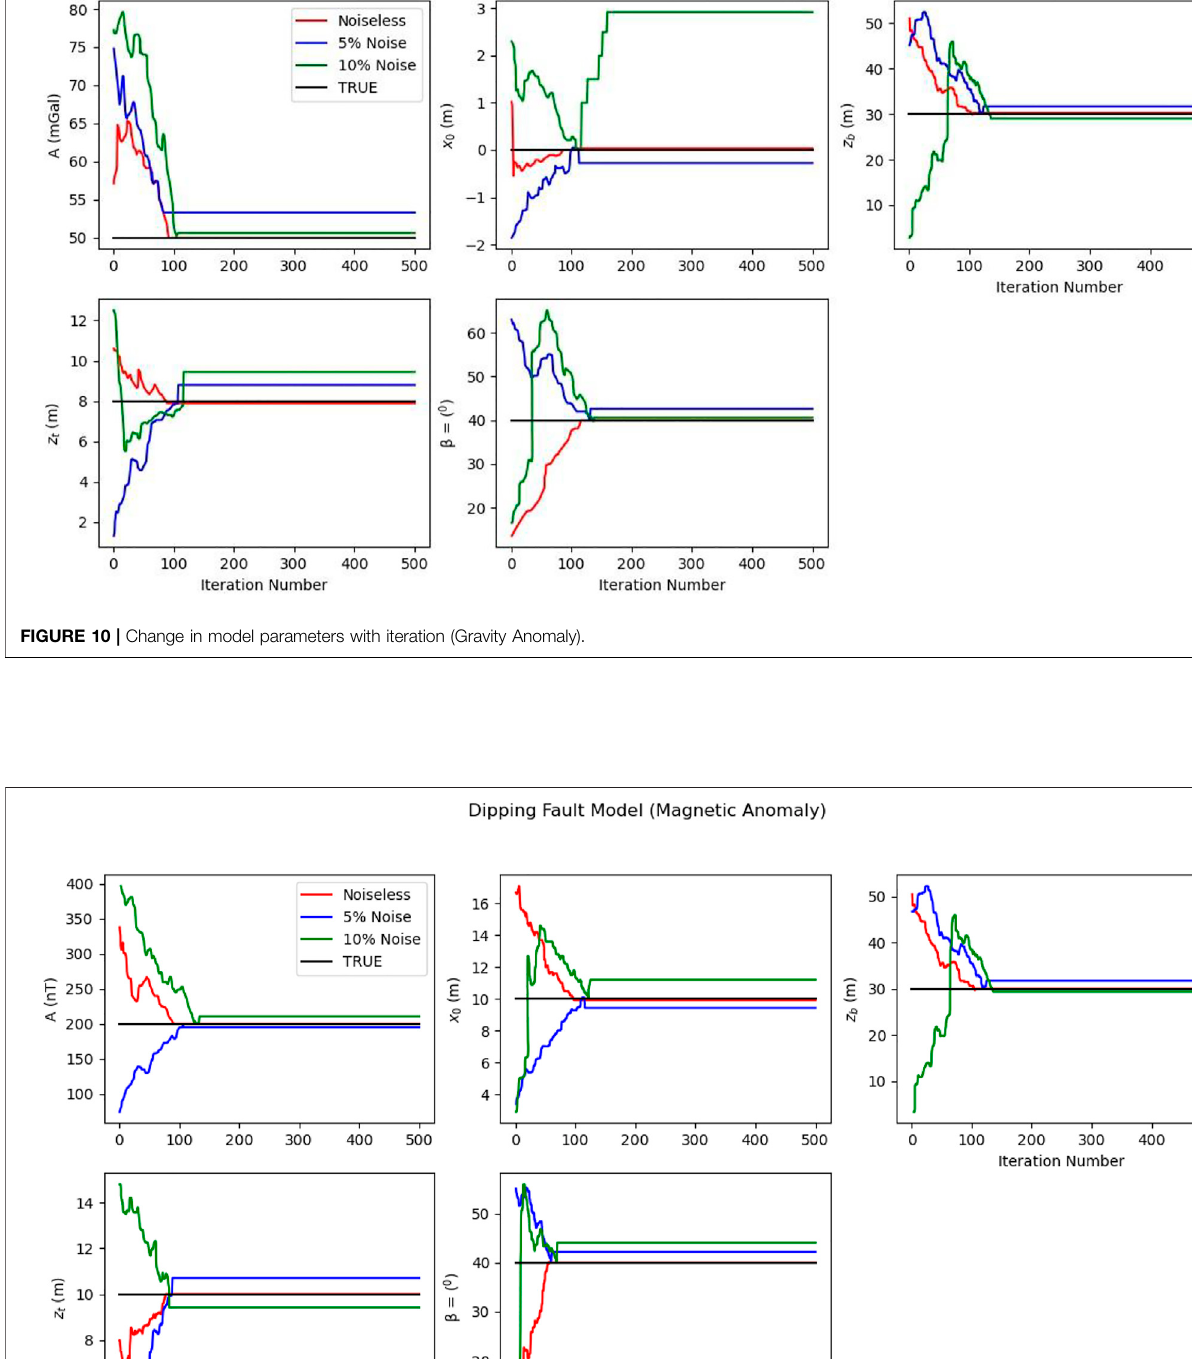
Frontiers in Earth Science |